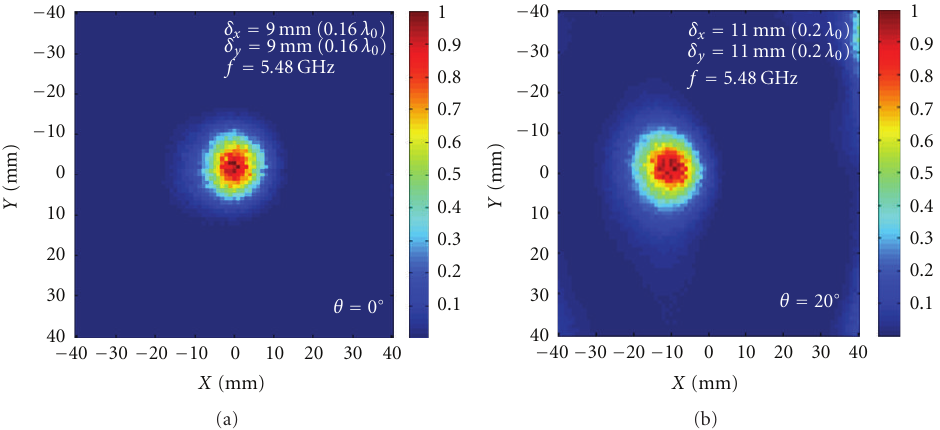
Figure 6: (a) Experimental verification of focusing a broad collimated ( Φ 80mm) beam to a spot size of 9mm × 9 mm ( λ 0 /6) at normal incidence. (b) Focusing to 11mm × 11mm ( λ 0 /5) at oblique